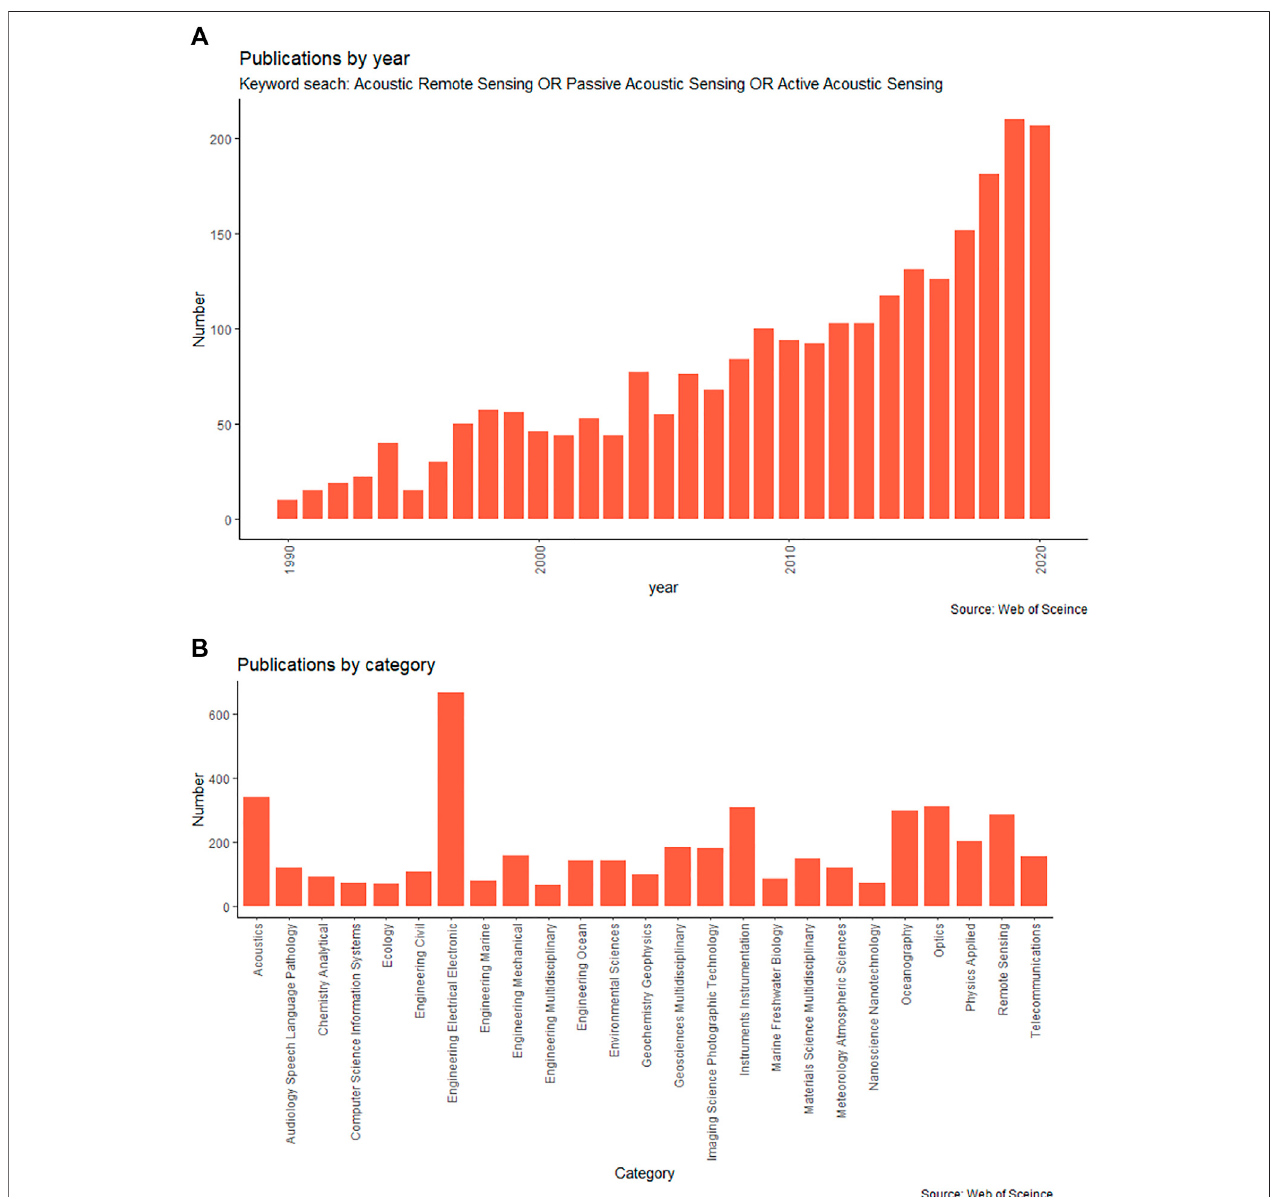
FIGURE3| Growthoftheacousticremotesensing fi eld. (A) :WebofSciencesearchshowingnumberofpublicationsbyyearusingthekeywords “ acousticremote sensing ” or “ activeacousticsensing ” or “ passiveacousticsensing ” ; (B) :NumberofpublicationsbyWebofScienceCategories,highlightingthekeyareaswhereacoustic remote sensing research is applied (top 25